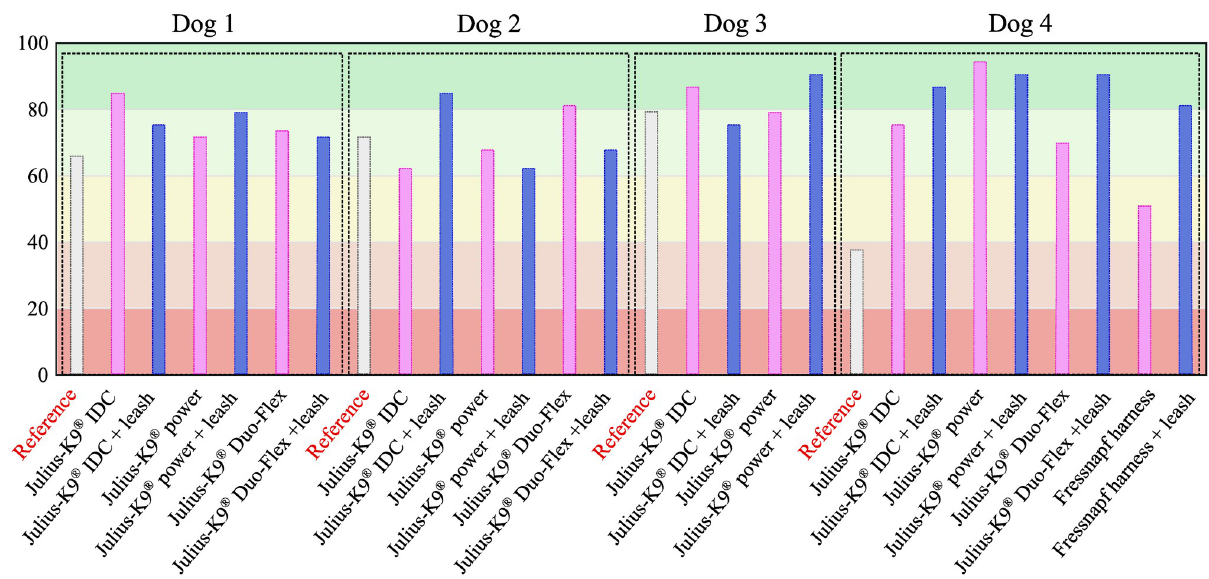
Fig 10. Result of Anderson-Darling normality test for each trial. Percentage of parameters of a given trial that passed the Anderson-Darling normality test ( p > 0.05)(53 parameters in total).